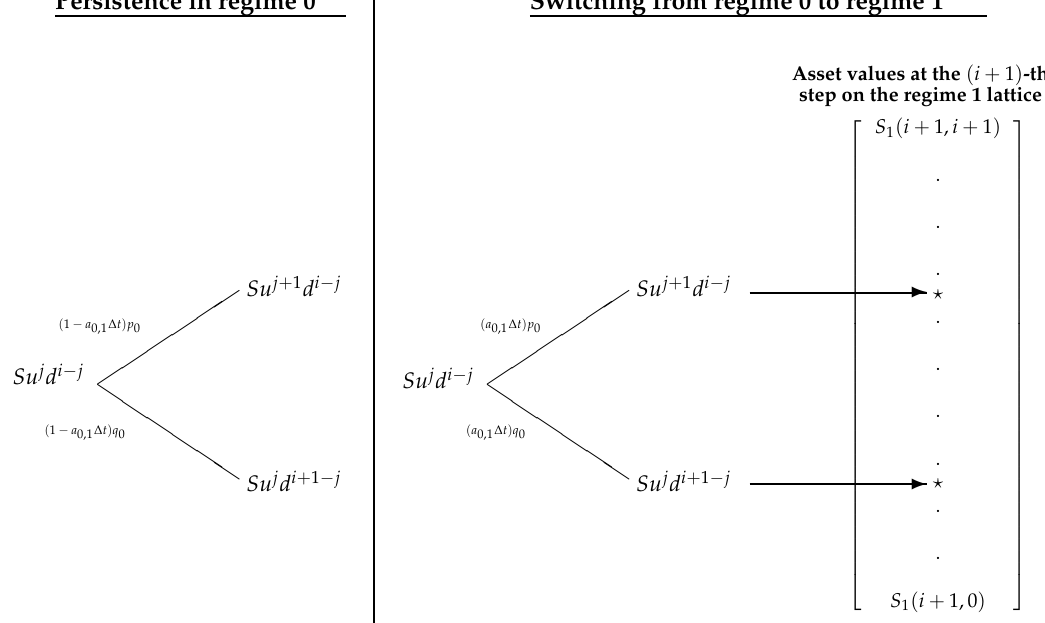
Figure 5. The asset evolution starting from a generic node ( i , j ) of the high-volatility